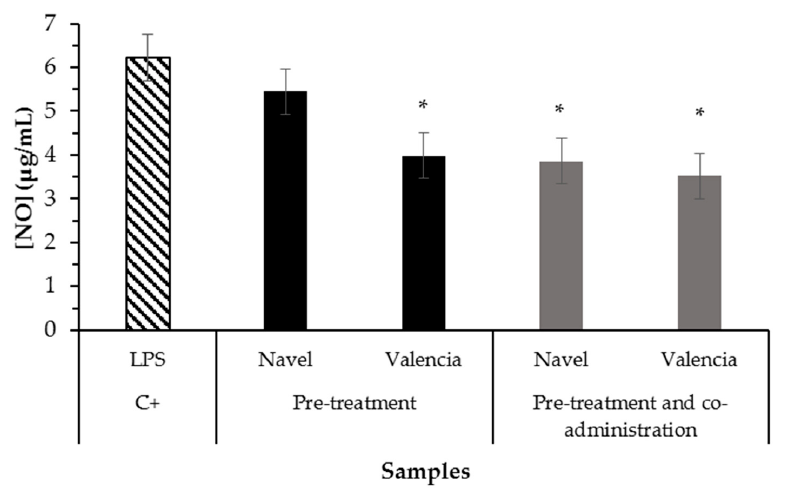
Figure 4. Effect of orange pomace bioaccessible fractions (250 µg/mL) on NO formation in RAW264.7 mouse macrophages. The pre-treatment assay consisted of cells treatment with samples during 24 h, followed by administration of LPS during 24 h. The pre-treatment and co-administration assay consisted of treatment with samples during 24 h, followed by co-administration of LPS and sample during 24 h. Bars represent mean values while error bars denote standard error of the mean (SEM). * Indicates statistical differences between mean values with p < 0.05 by Tukey test when compared to the control (C+).